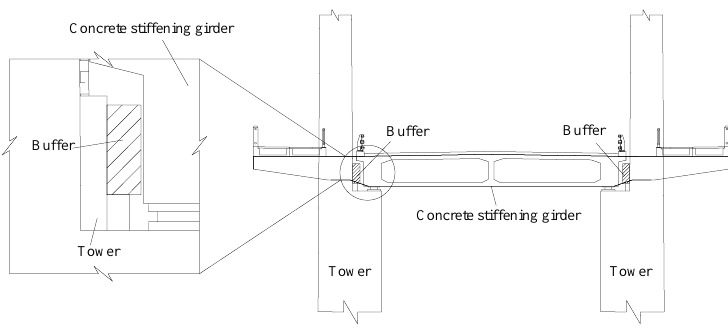
Figure 3. Installation and composition of the lateral seismic block.